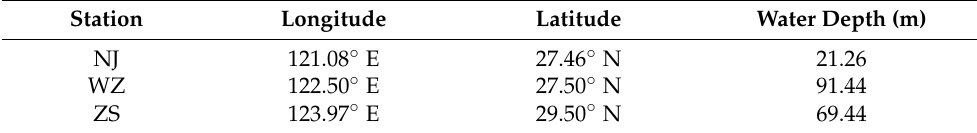
Table 1. Observation Site